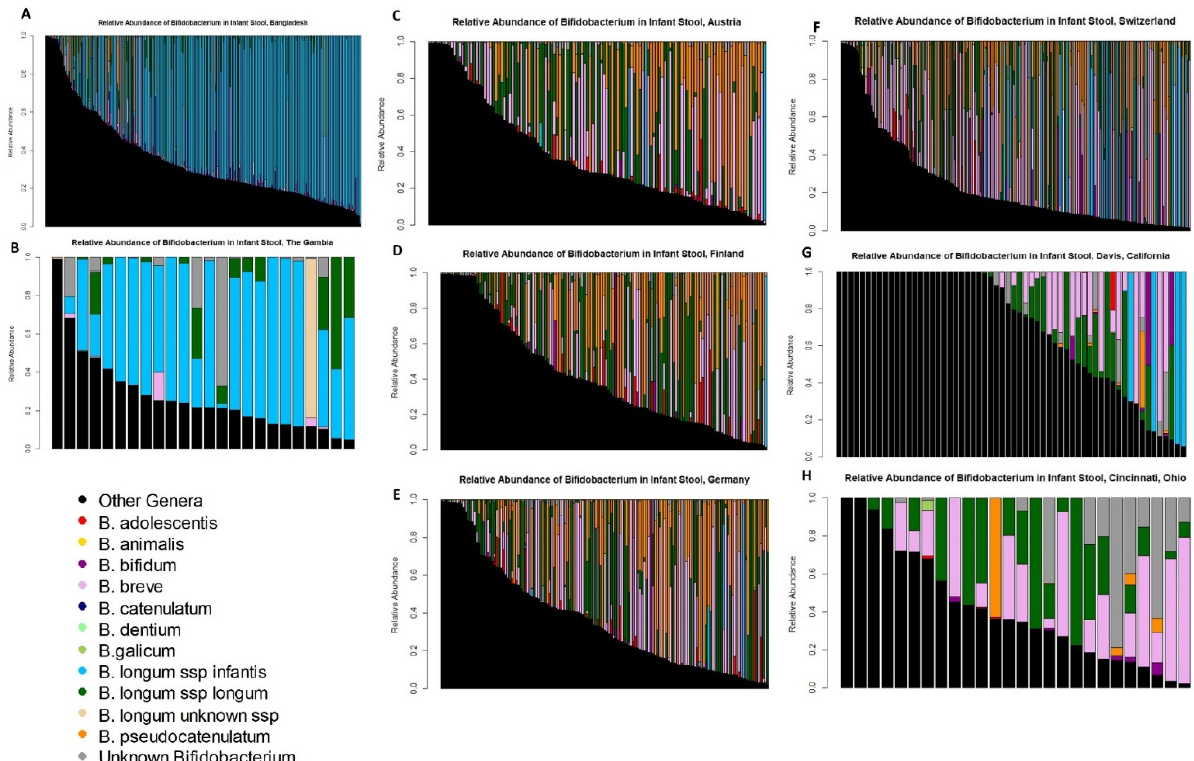
Figure 2. Relative abundance of different Bifidobacterium species in infant stools. Each bar represents the microbiome from an individual infant; cohorts with smaller numbers of infants may fail to identify the presence of rarer Bifidobacterium species in those cohorts by chance alone. B. longum subsp. infantis is in blue, non- Bifidobacterium taxa are black. ( A ) Bangladesh, ( B ) the Gambia, ( C ) Austria, ( D ) Finland, ( E ) Germany, ( F ) Switzerland, ( G ) Davis, CA, USA, ( H ) Cincinnati, OH, USA.